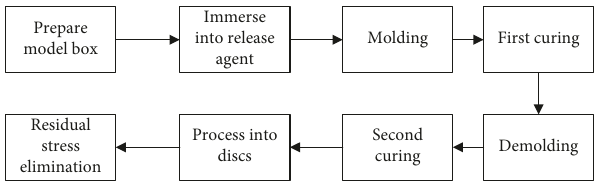
Figure 3: Flow chart of the model